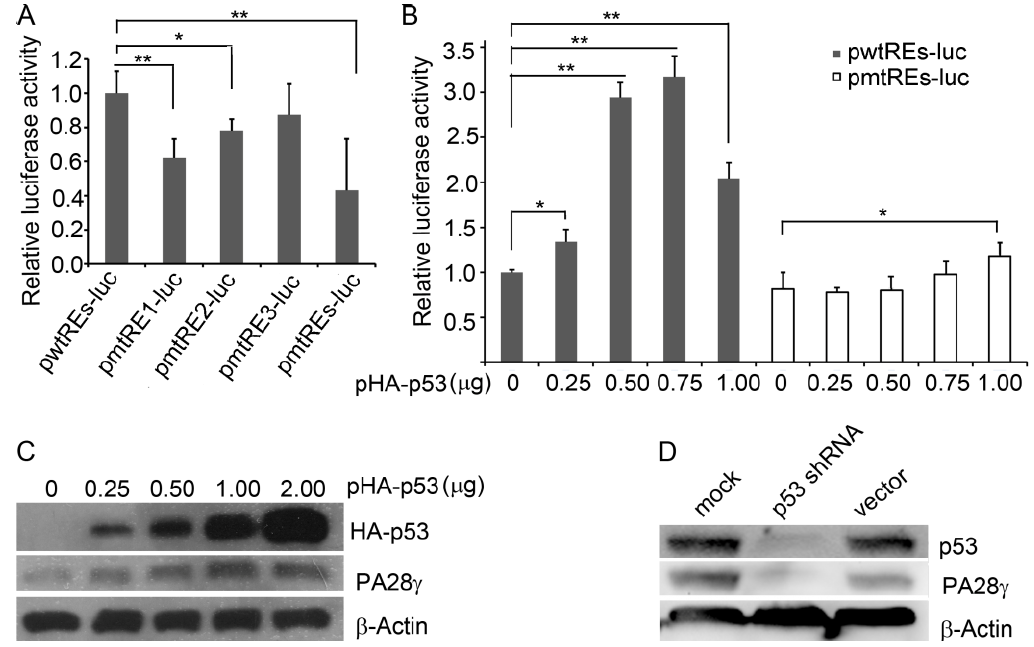
Figure 3. The p53 protein stimulates the expression of the human PA28 γ gene. ( A ) HEK293 cells were transfected with pwtREs-luc and its mutant plasmids, or ( B ) co-transfected with pwtREs-luc (or pmtREs-luc) and pHA-p53. Luciferase activity